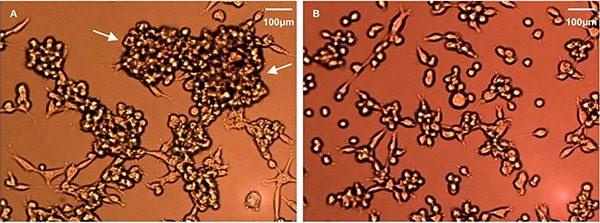
Breast cancer stem cells (BCSCs) after 24-h incubation with non-alkalinized medium (A) and 100 mM NaHCO3 alkalinized medium (B) observed using an inverted microscope at 10× magnification. In non-alkalinized medium, BCSCs tended to grow as cell aggregates and form mammospheres (white arrows). The number of viable BCSCs and mammospheres were reduced in alkalinized medium.